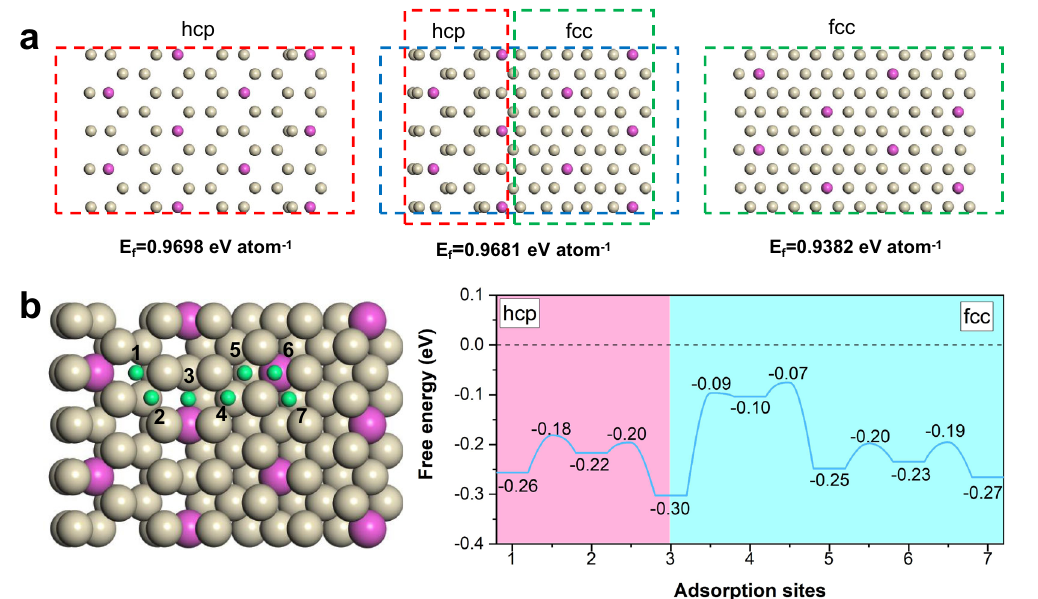
Fig. 4 | DFT calculations of RhMo NSs. a The geometric structures for pure hcp, polymorphic, and pure fcc RhMo and their formation energies per atom. b Geometry con fi gurations for seven potential active sites on the surface of RhMo